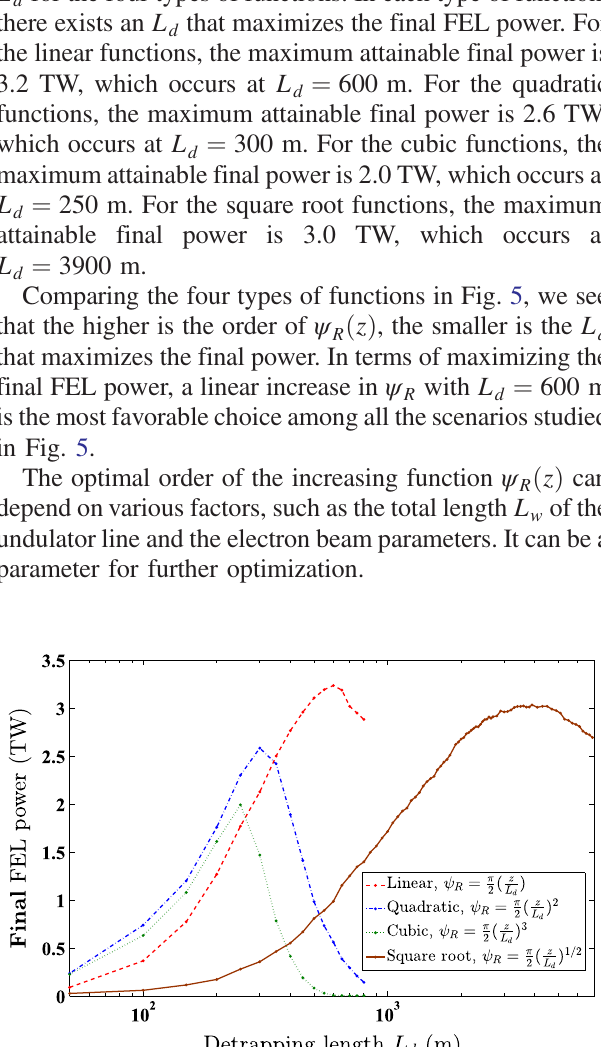
ð z Þ , namely, linear R ∝ z 2 ), cubic ( ψ ∝ z 3 ), and square root R R ¼ 200 m) and is plotted as a function w . Note that the L axis is on a d d